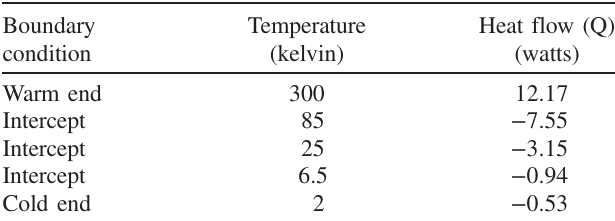
TABLE I. Static heat